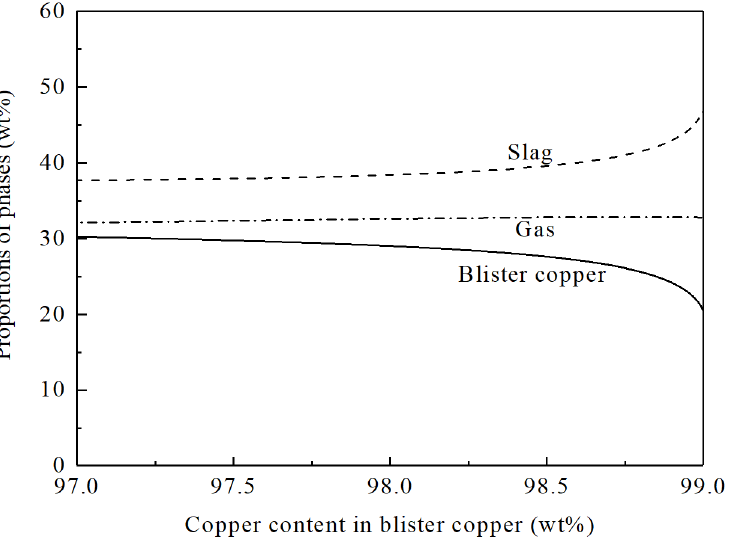
Figure 2. Effect of copper content in blister copper on proportions of the phases at 1290 °C with a slag Fe/SiO 2 ratio of 1.7.